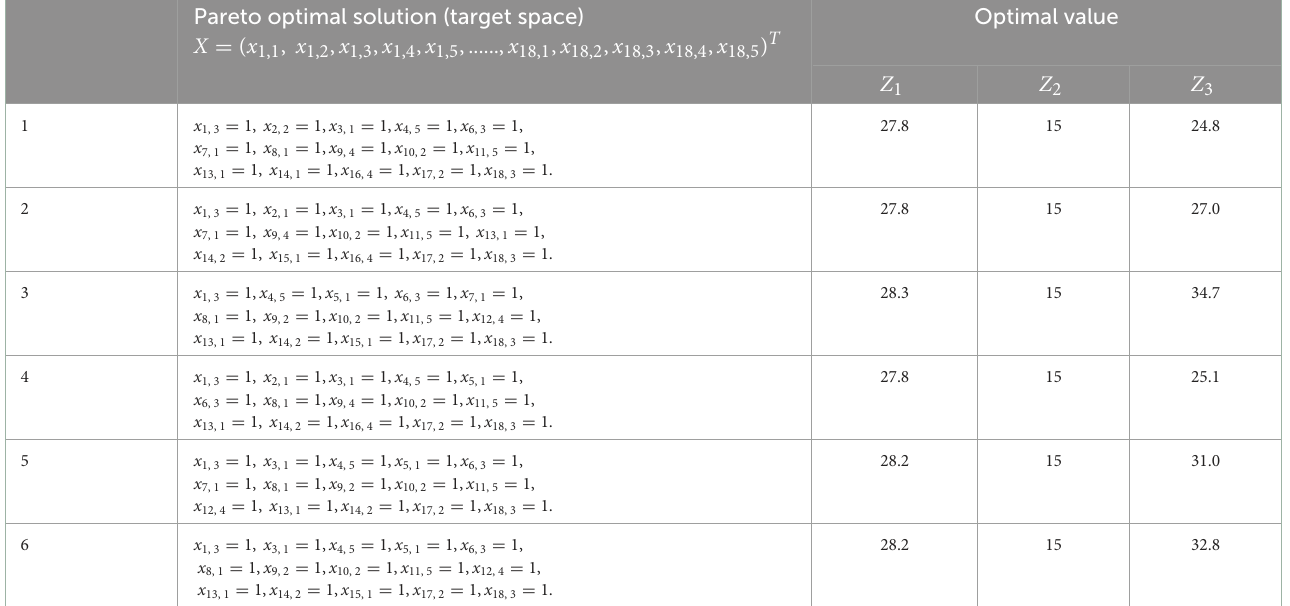
TABLE 6 Pareto optimal solutions. Pareto optimal solution (target